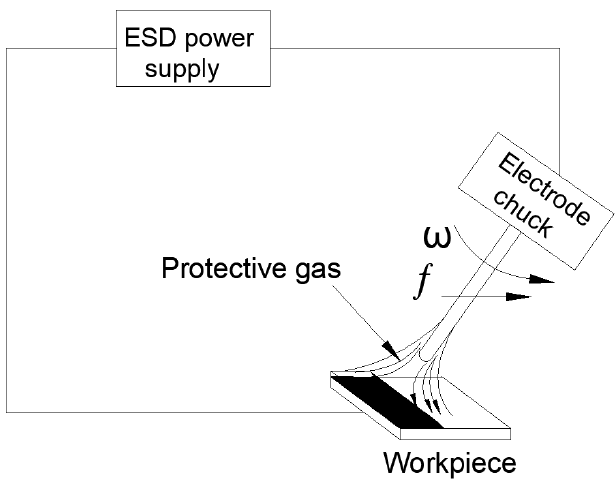
Figure 2. Diagram of ESD machining.